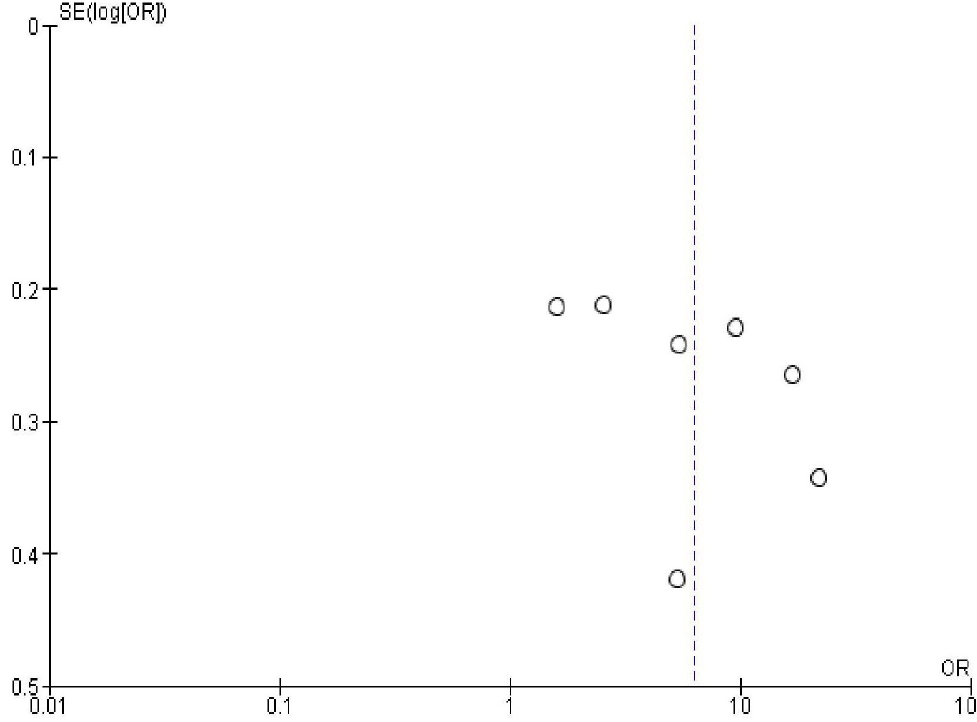
Fig 15. Publication bias on resumption of sexual activity after the last